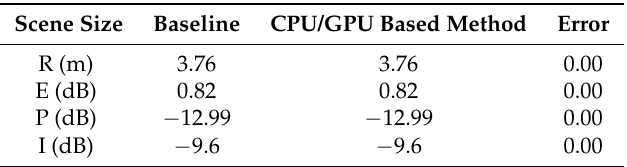
Figure 12. The imaging results from serial imaging ( Left ) and CPU/GPU collaborative computing ( Right ). Table 6. Imaging indicators of azimuth direction.